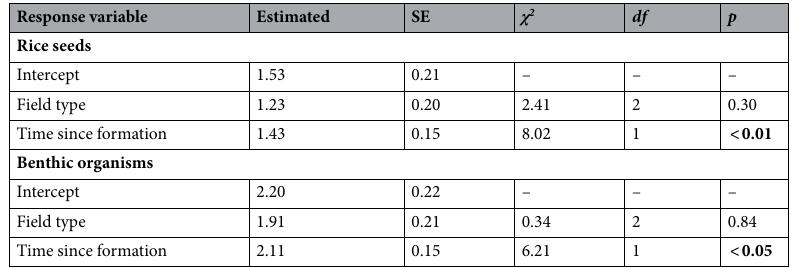
Table 3. Results of the generalized linear mixed model examining the impact of field type and time since habitat formation on the abundance and distribution of potential food sources for shorebirds. The sample sizes of rice seeds and benthic organisms were both 56. Each food source (rice seeds and benthic organisms) was analyzed using density (individuals per paddy) as the response variable, field type (plowed, harrowed, or seeded) and time since habitat formation as the explanatory variables, and survey time and individual paddy as stochastic variables. SE = standard error.